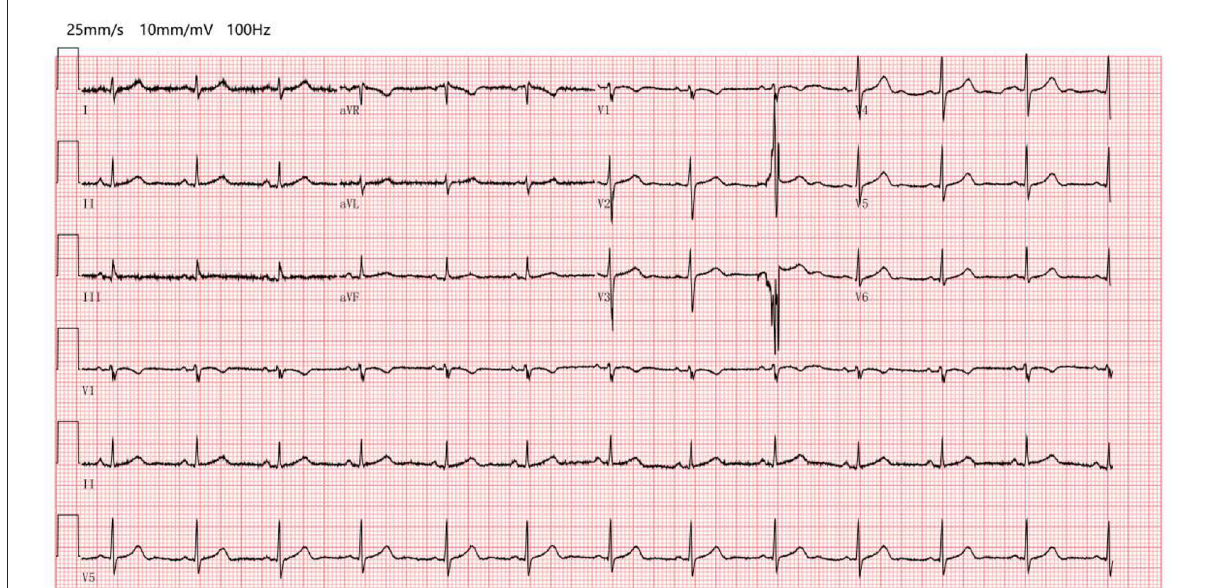
FIGURE1 Electrocardiograms at admission (electrocardiograms showed a heart rate of only 74 beats per minute with sinus rhythm despite a body temperature of 39.1 ◦ C, without arrhythmia, no shortening of the PR segment, ST elevation or depression, and conduction block or T wave change).